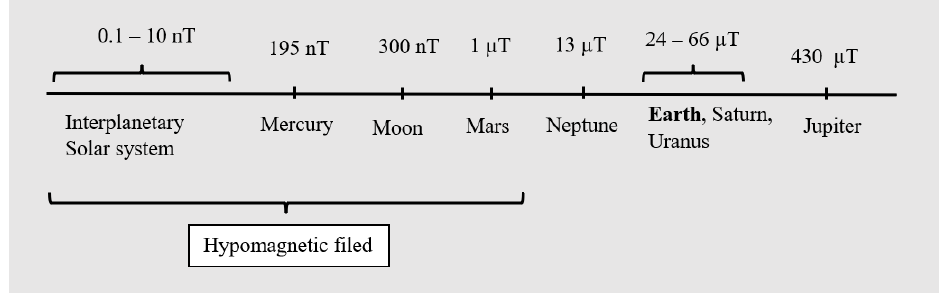
Figure 1. Presence of hypomagnetic field in the solar system [3].